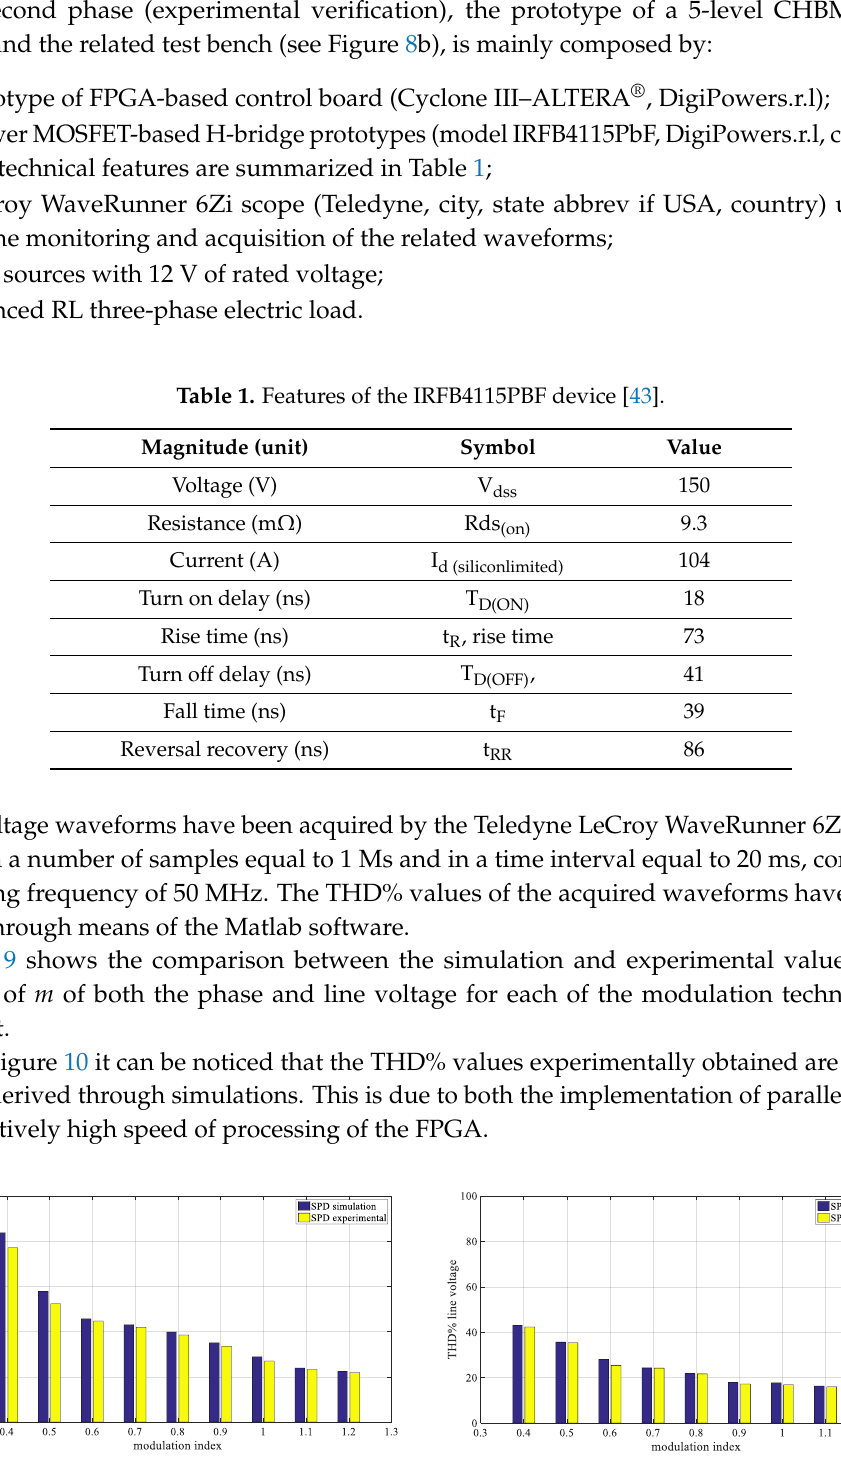
Table 1. Features of the IRFB4115PBF device